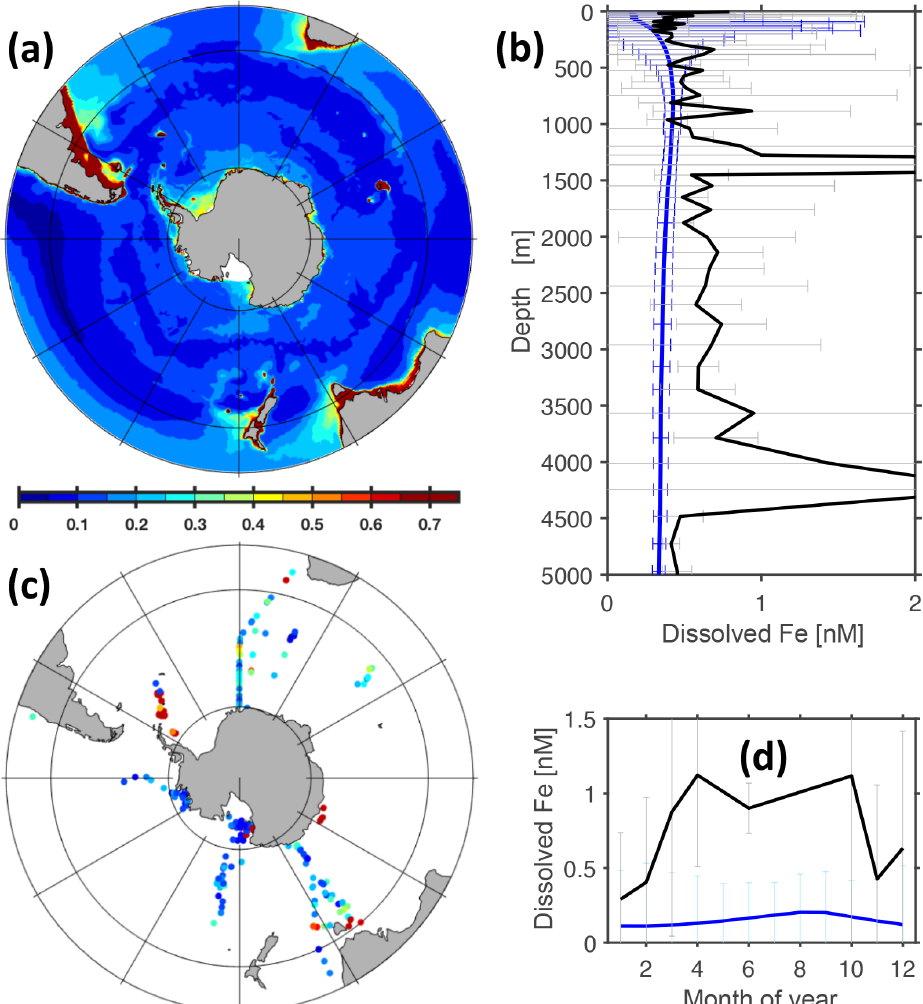
Figure 25. Comparison of simulated with observed dissolved iron concentrations. Panel (a) refers to simulated surface iron concentrations (reference simulation, averaged over nominal years 1993 to 1998). The color bar denotes iron concentrations in units of nMFe. Panel (b) shows simulated (blue line) and observed (black line) concentrations averaged horizontally in the Southern Ocean (i.e., south of 40 ◦ S), along with their respective spatial standard deviations (grey and blue horizontal bars). Panel (c) refers to observed surface iron concentrations (compiled by Tagliabue et al., 2012, and Mawji et al., 2014). (The color bar matches panel a .) Panel (d) depicts the simulated (blue line) and observed (black line) seasonal cycles of dissolved iron concentration at the surface calculated as monthly means averaged over the Southern